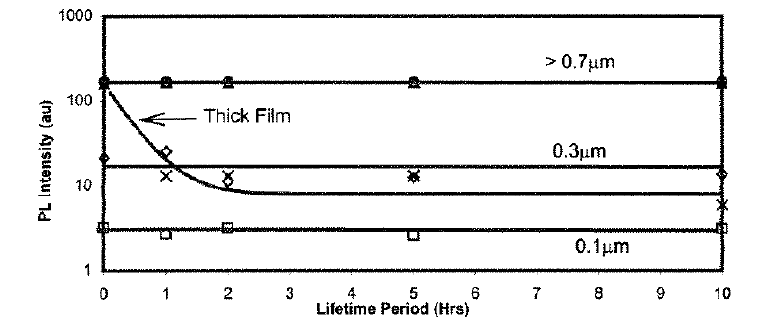
Figure 30. The variation in intensity with time (hours) at a constant thermal exposure of 1,200 o C for thin coatings (0.1 µm-3 µm) and thick film coatings (10 µm)